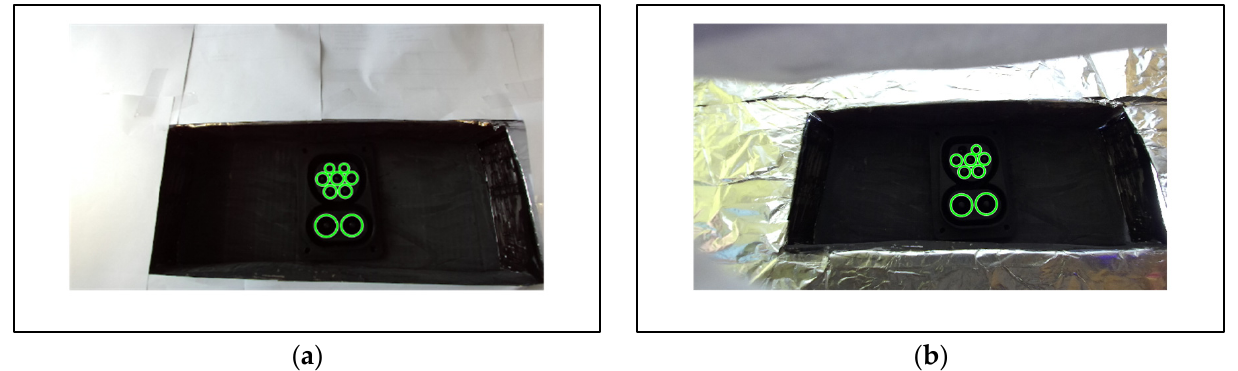
Figure 17. Results of the comparison with Circular Hough Transfom: ( a ) Correct detection, ( b ) in- complete detection.